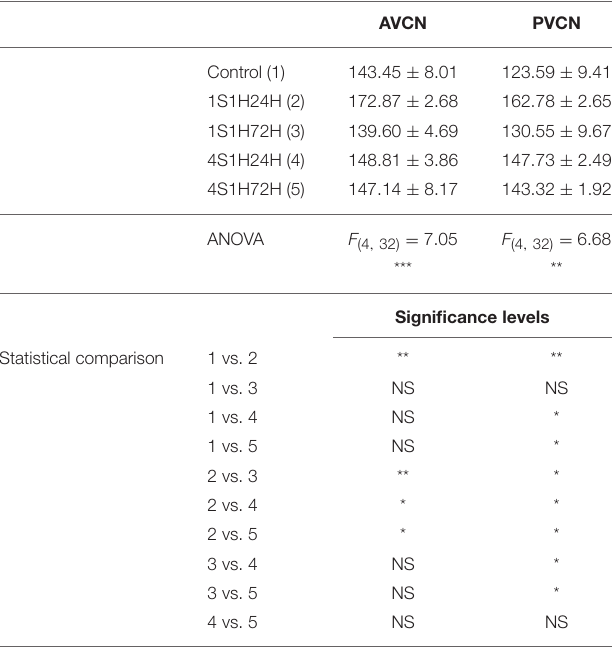
TABLE 8 | Mean gray level of NOS immunostaining in the AVCN and PVCN in control and experimental